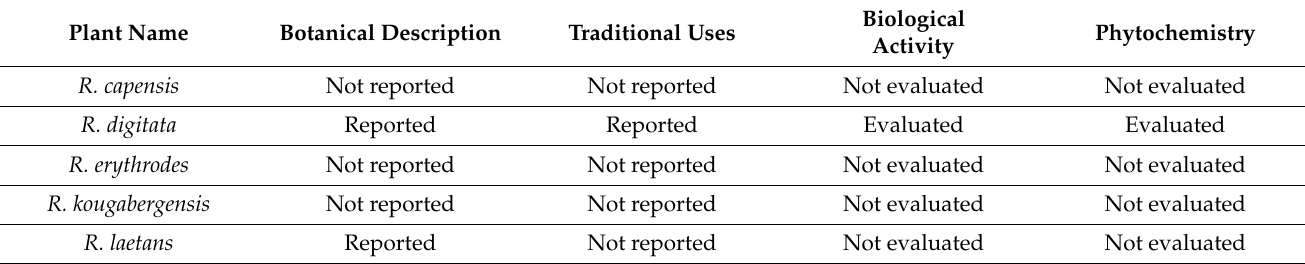
Table 2. Summary of phytochemistry, ethnomedicinal, and biological studies reported for Rhoicissus